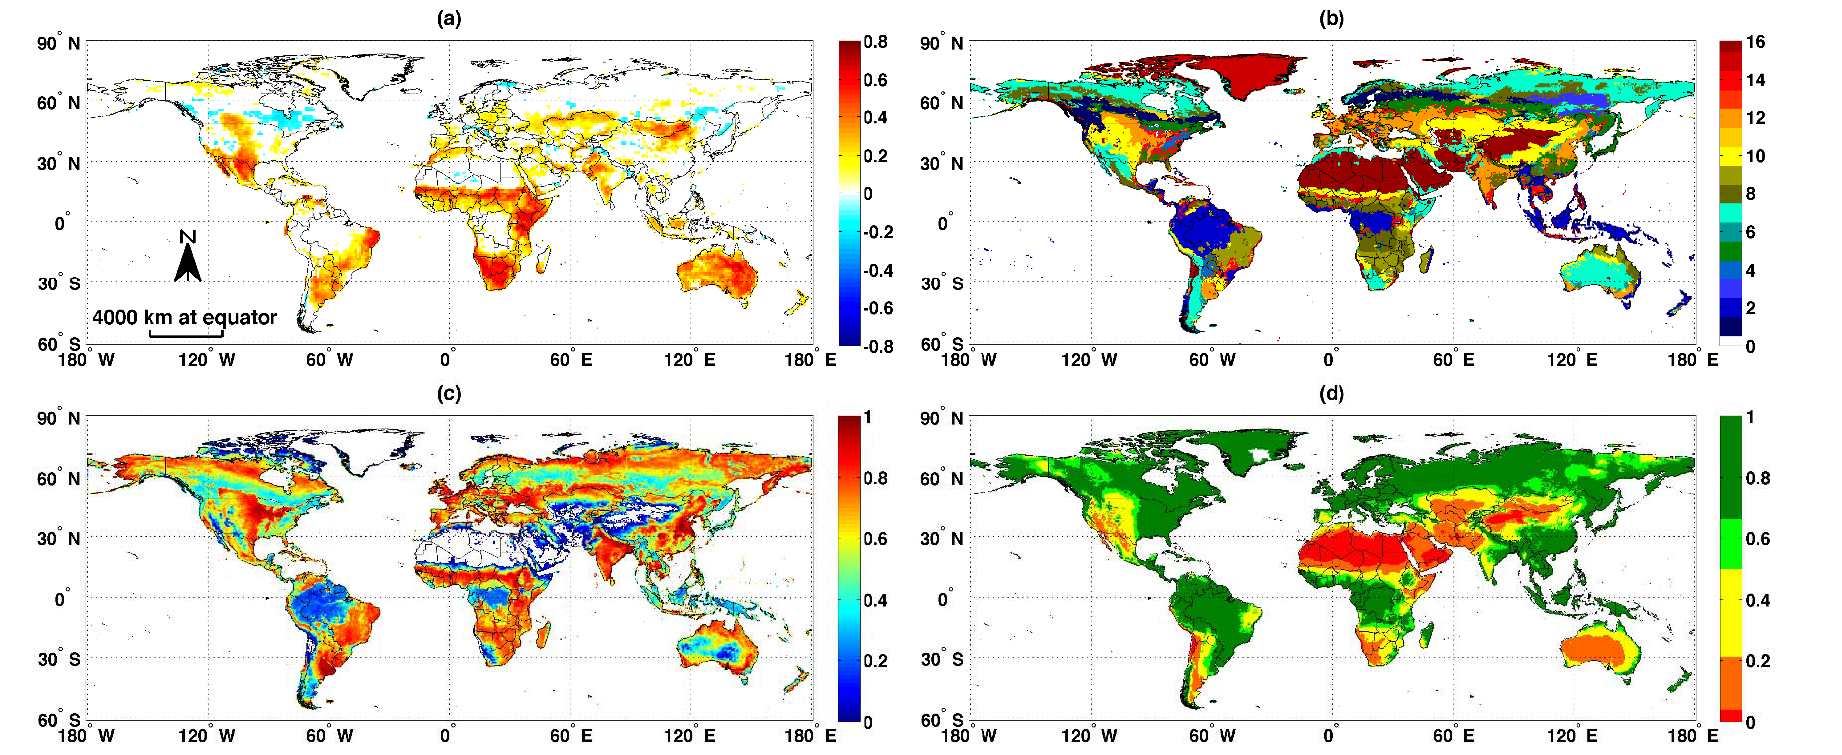
Figure 1. Global maps of ( a ) correlation coefficients (corrected for temporal autocorrelation, p* < 0.05) between all monthly Global Inventory Modeling and Mapping Studies normalized difference vegetation index (GIMMS NDVI) and 1-month lead precipitation anomalies for 1982–2010 (N = 347 months), ( b ) 2001 land cover (MCD12C1) [57], ( c ) herbaceous cover fraction (MOD44B) [58], and ( d ) aridity index (AI) [59]. 26.1% of land grid cells have significant positive correlations (a). Land cover in (b) is classified as: 1—evergreen needleleaf